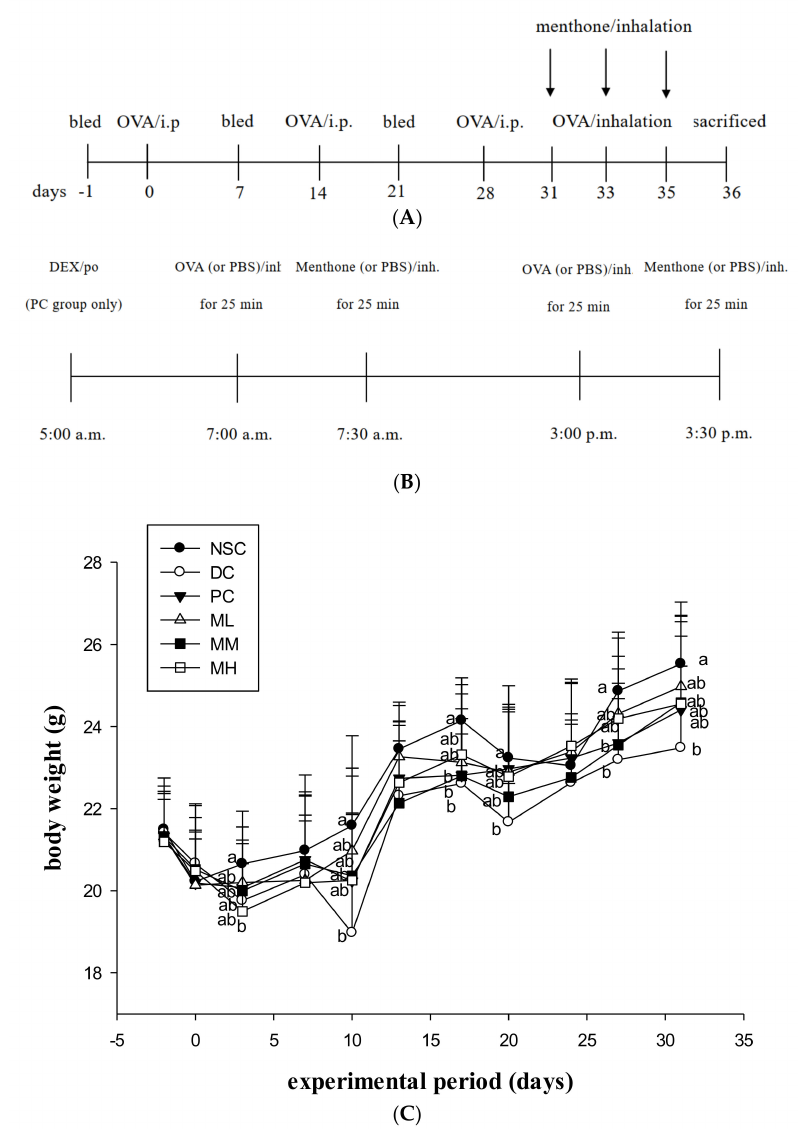
Figure 1. Effects of menthone inhalation with different doses on body weight changes of OVA/Al- sensitized and challenged BALB/c asthmatic mice. Values are means ± SD ( n = 15). Values among DC, PC, ML, MM, and MH groups at the same experiment point not sharing a common small letter (a, b) are significantly different ( p < 0.05) from each other, assayed by one-way ANOVA, followed by Duncan’s multiple range test. NSC: non-sensitized control; DC: dietary control; PC: positive control; ML: low dose menthone (0.3 mg/L); MM: medium dose menthone (1.2 mg/L); MH: high dose menthone (6 mg/L). ( A ) experimental design; ( B ) menthone inhalation treatment; ( C ) body weight changes of experiment